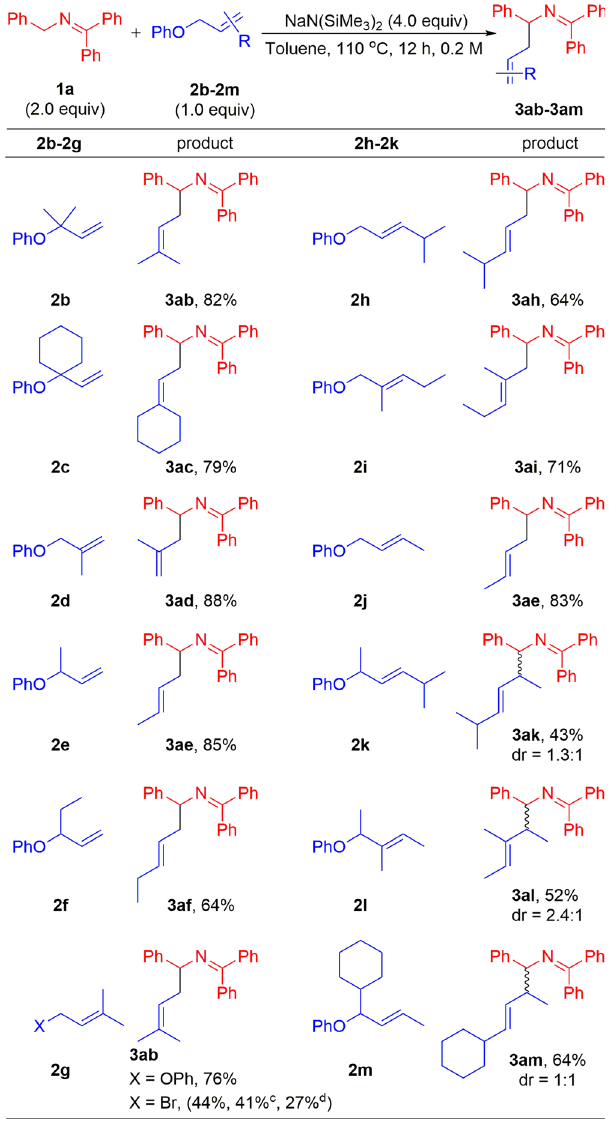
Fig. 4 Substrate scope of allyl phenyl ethers a,b . a Reactions were conducted on a 0.6 mmol scale using 2.0 equiv. ketimine 1a , 1.0 equiv. allyl ether, and 4.0 equiv. NaN(SiMe 3 ) 2 at 0.2 M and 110 °C. b Yield of isolated product after chromatographic puri fi cation. c 3.0 equiv. NaN(SiMe 3 ) 2 . d 1.0 equiv. ketimine 1a . dr, diastereomeric ratio.